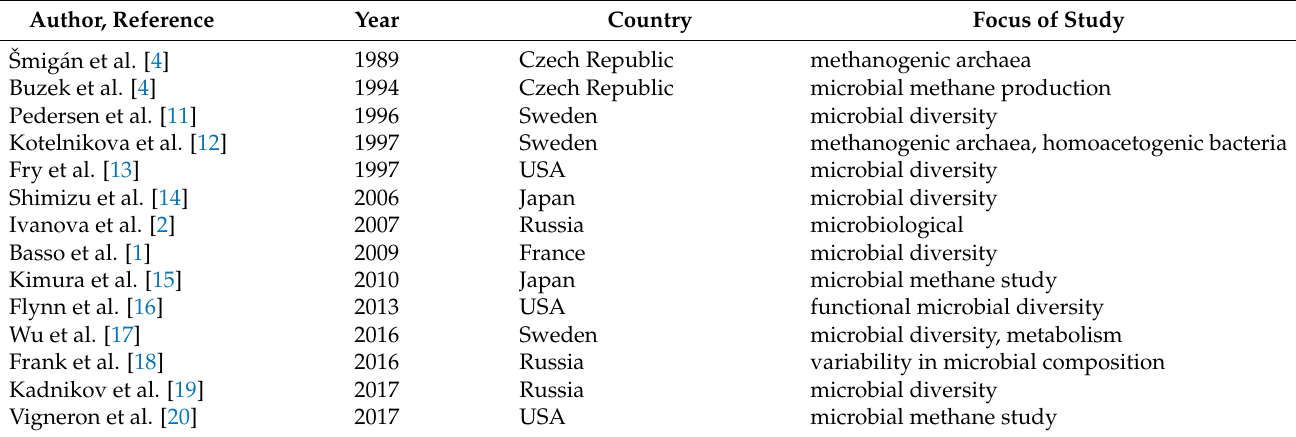
Table 1. Selected investigations performed in similar rock